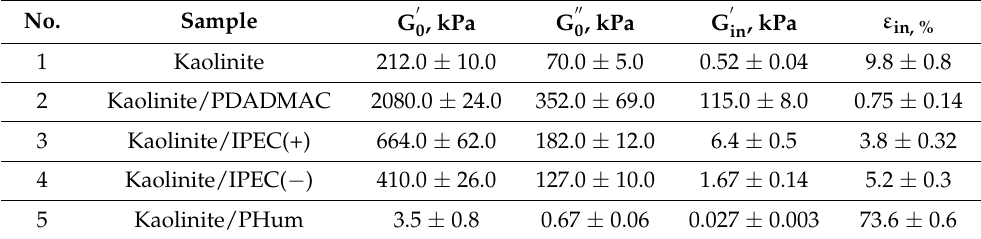
Table 1. Rheological characteristics of kaolinite-polymer